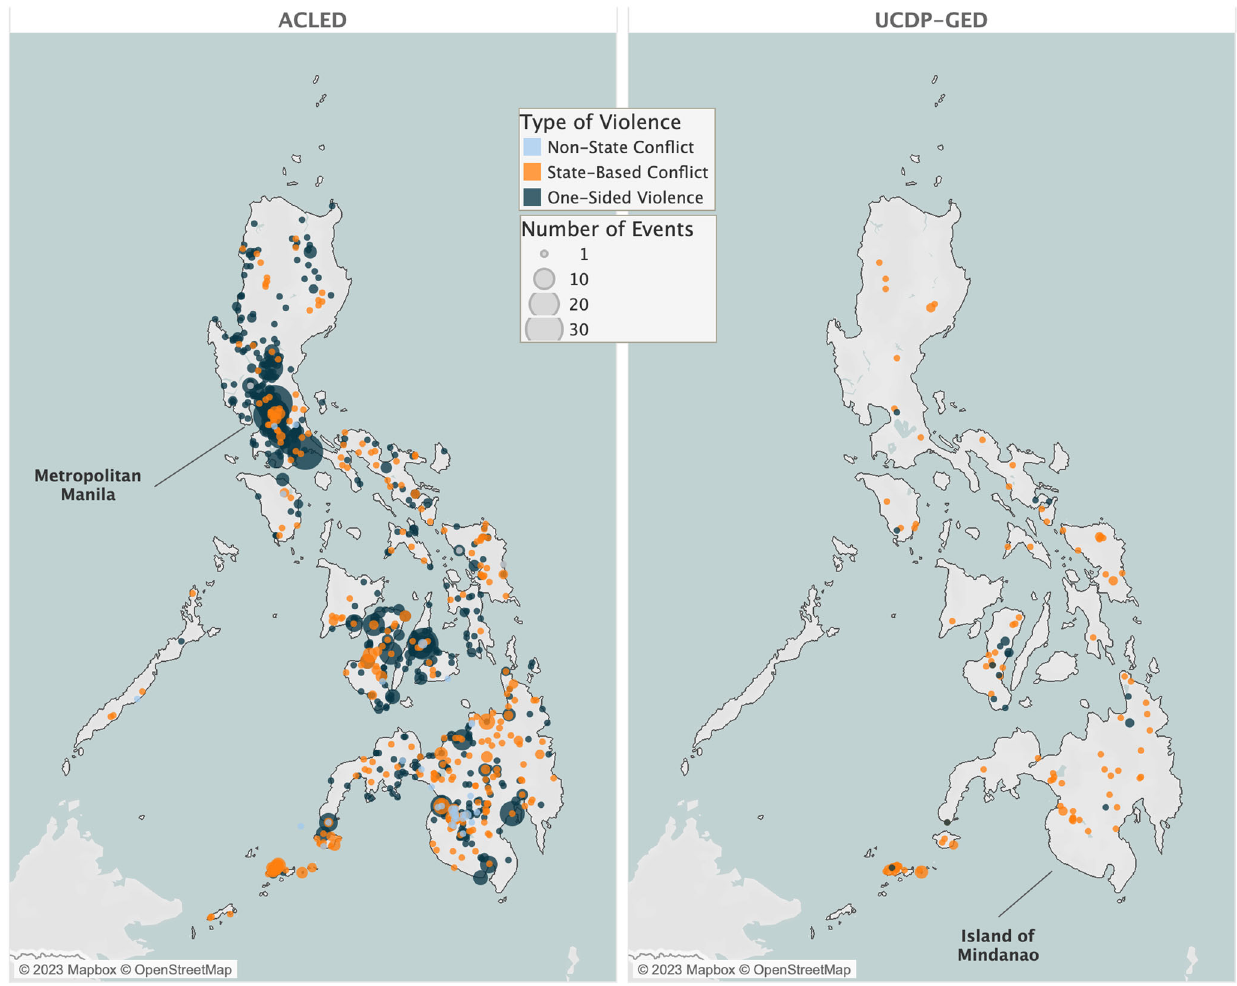
Fig. 1 Violence in the Philippines, 2020, according to ACLED vs. UCDP-GED. The categorizations used on these maps defers to UCDP-GED ’ s categorization of con fl ict: state-based con fl ict, non-state con fl ict, and one-sided violence. ACLED data are mapped onto those categorizations as follows: fi rstly, determining whether an organized, political violence event involves targeting of civilians (i.e. an interaction code including a 7), and if so, categorizing it as one-sided violence ; if not, determining whether an organized, political violence event involves the state (i.e. an interaction code including a 1), and if so, categorizing it as state-based con fl ict ; and thirdly, determining whether an organized, political violence event involves non-state actors (i.e. an interaction code including a 2, 3, and/or 4), and if so, categorizing it as non-state con fl ict . Comparison of the global, public datasets under review for events captured in the Philippines in 2020. Figure created by